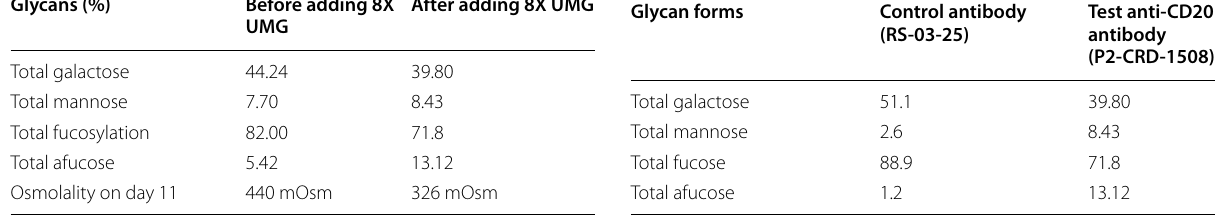
Table 3 Glycan data showing increase in afucose before and after addition of 8X UMG Glycans (%) Before adding 8X UMG